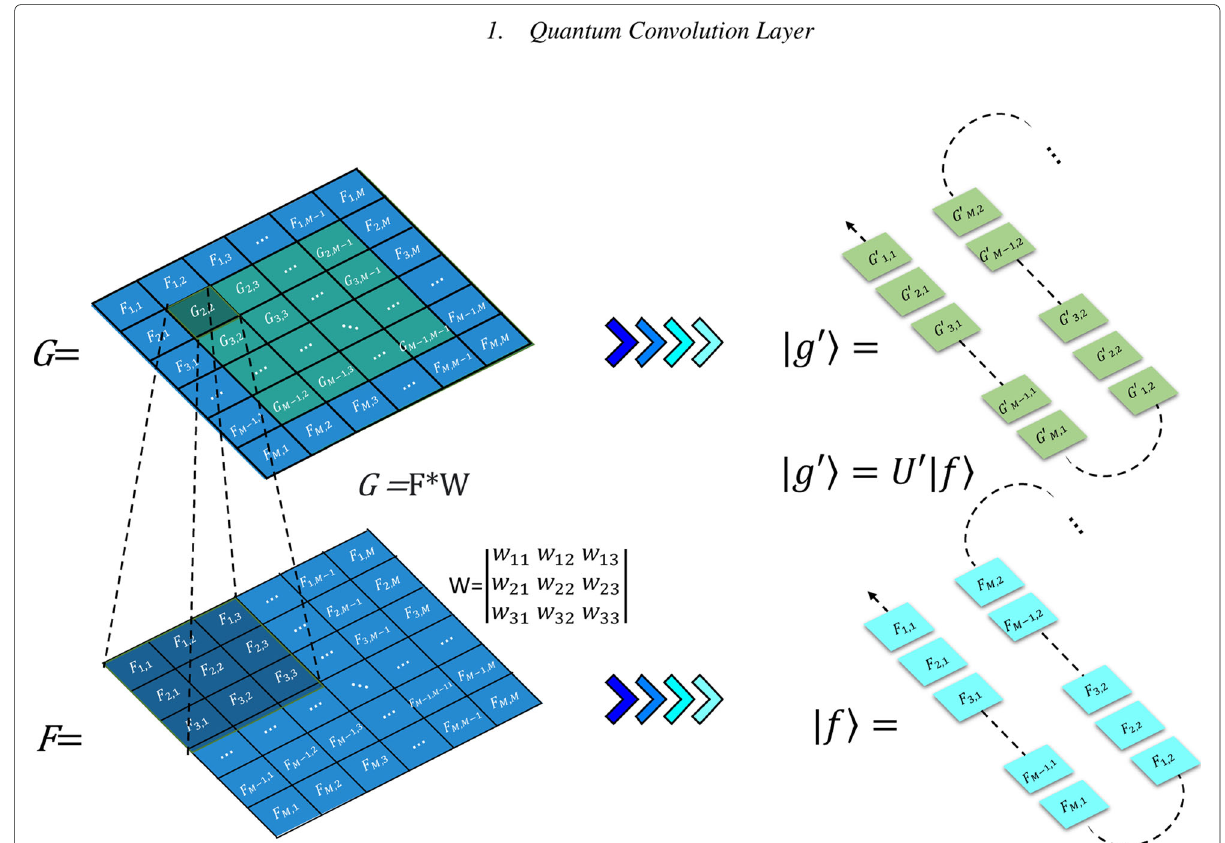
Fig. 1 Comparison of classical convolution processing and quantum convolution processing. F and G are the input and output image data, respectively. On the classical computer, a M × M image can be represented as a matrix and encoded with at least 2 n bits [ n = (cid:4) log 2 ( M 2 ) (cid:5) ]. The classical image transformation through the convolution layer is performed by matrix computation F ∗ W , which leads to (cid:2) ((cid:2) − 1 ) m . The same image can be represented as a quantum state and encoded in at least n qubits on a quantum computer. x ((cid:2)) i , j = a , b = 1 w a , b x i + a − 2, j + b − 2 The quantum image transformation is realized by the unitary evolution U on a specific quantum